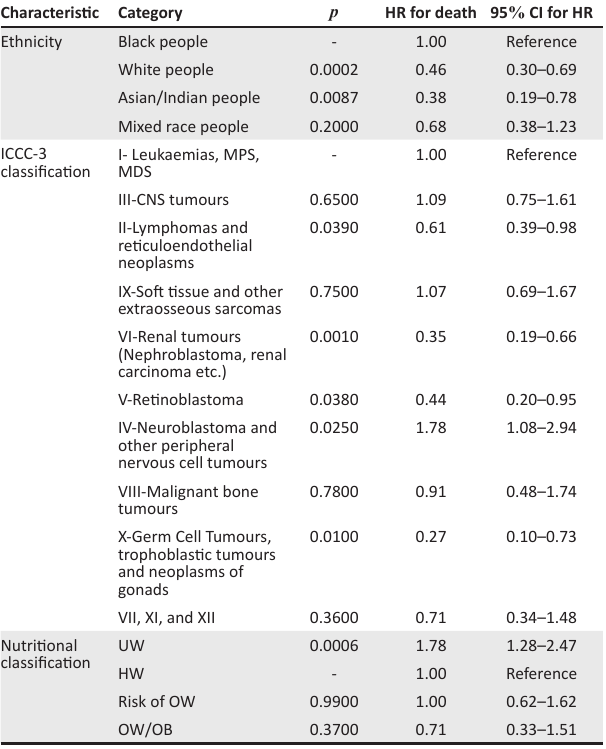
TABLE 2 : Univariable analysis: Childhood cancer determinants of overall survival ( n = 677). Characteristic